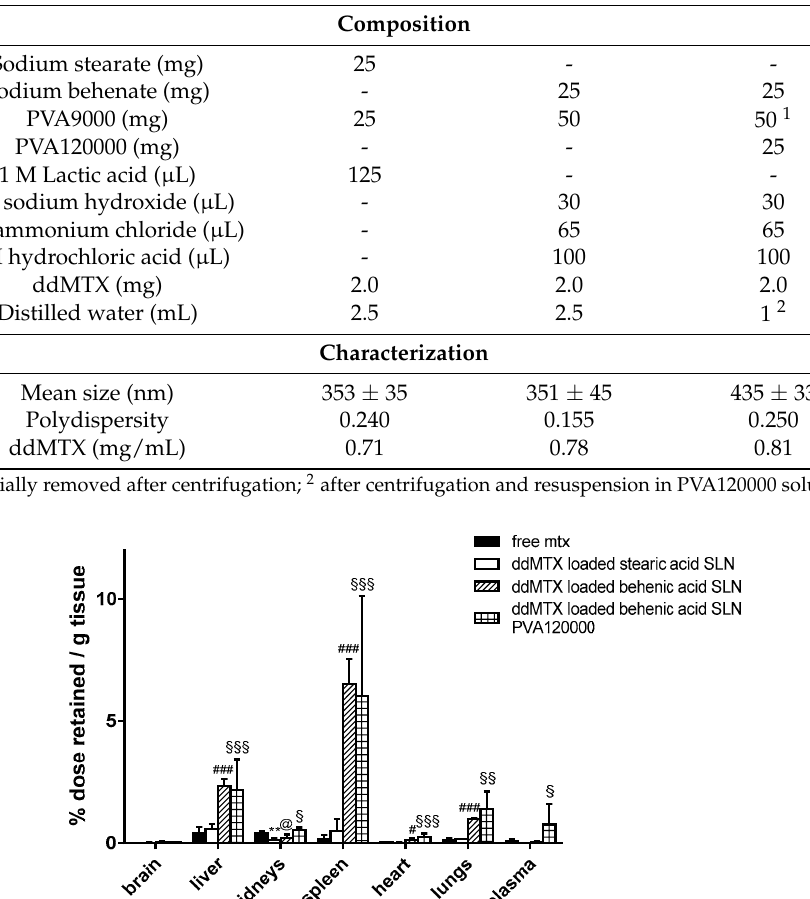
5 M ammonium chloride ( µ L)